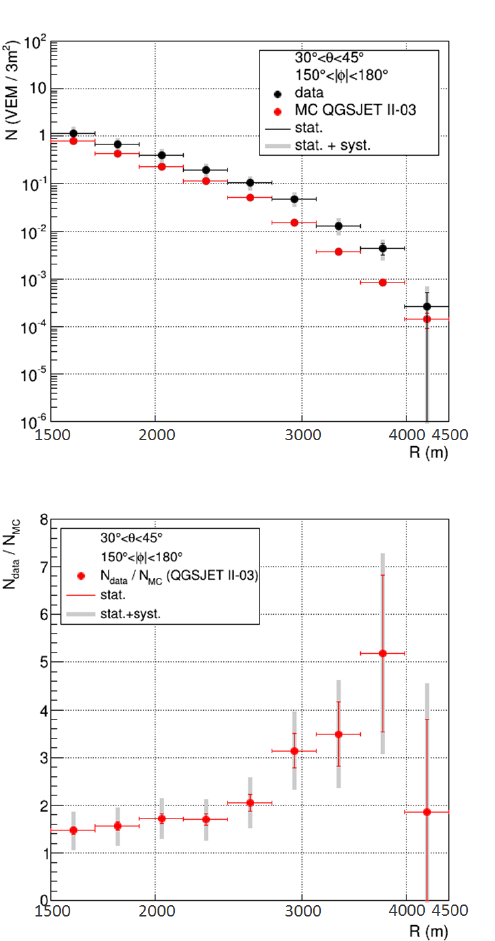
Figure 8. (Top) The simulated signal size in TA SD as a function of R in a unit of VEM / 3m 2 for di ff erent type of particles and sum of them. (bottom) The muon purity as a function of R . (Figure from [6])